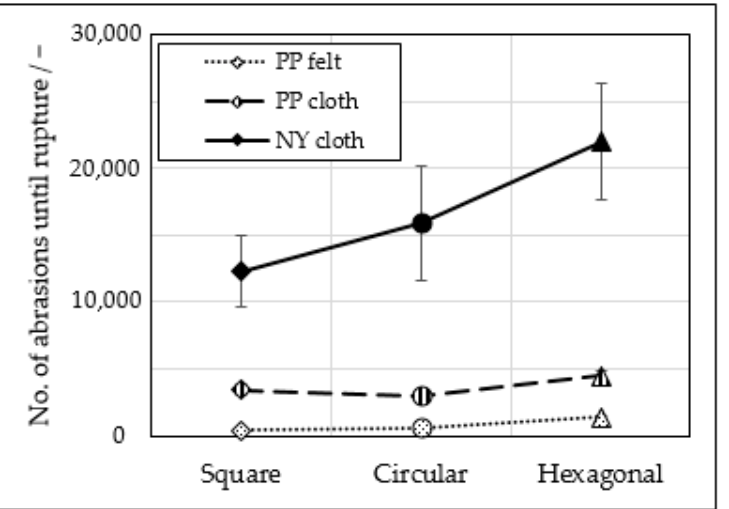
Figure 11. Number of abrasions until rupture of PP felt, PP cloth and NY cloth for the square, circular and hexagonal edge geometry.